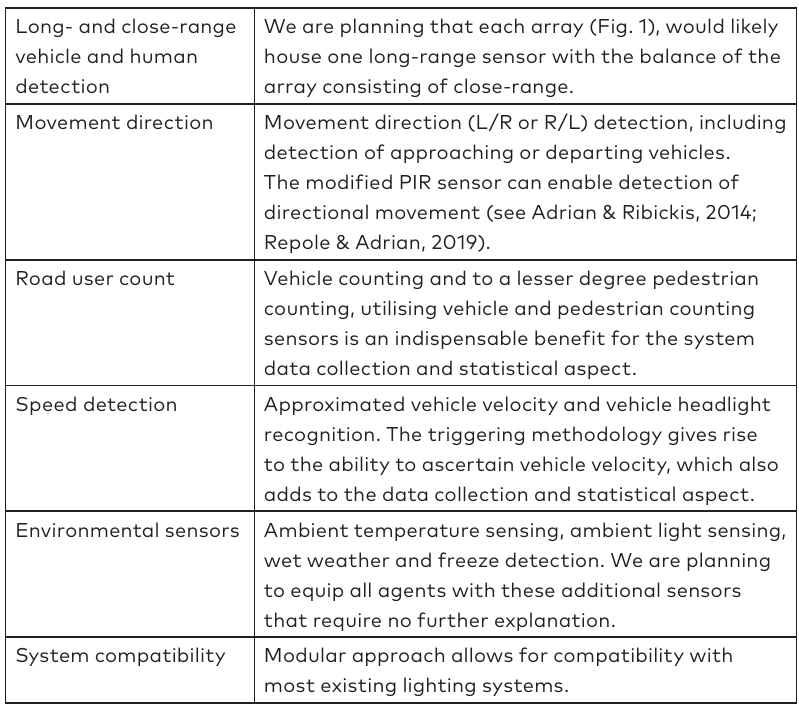
Table 1. Hybrid sensor (operating under assessed